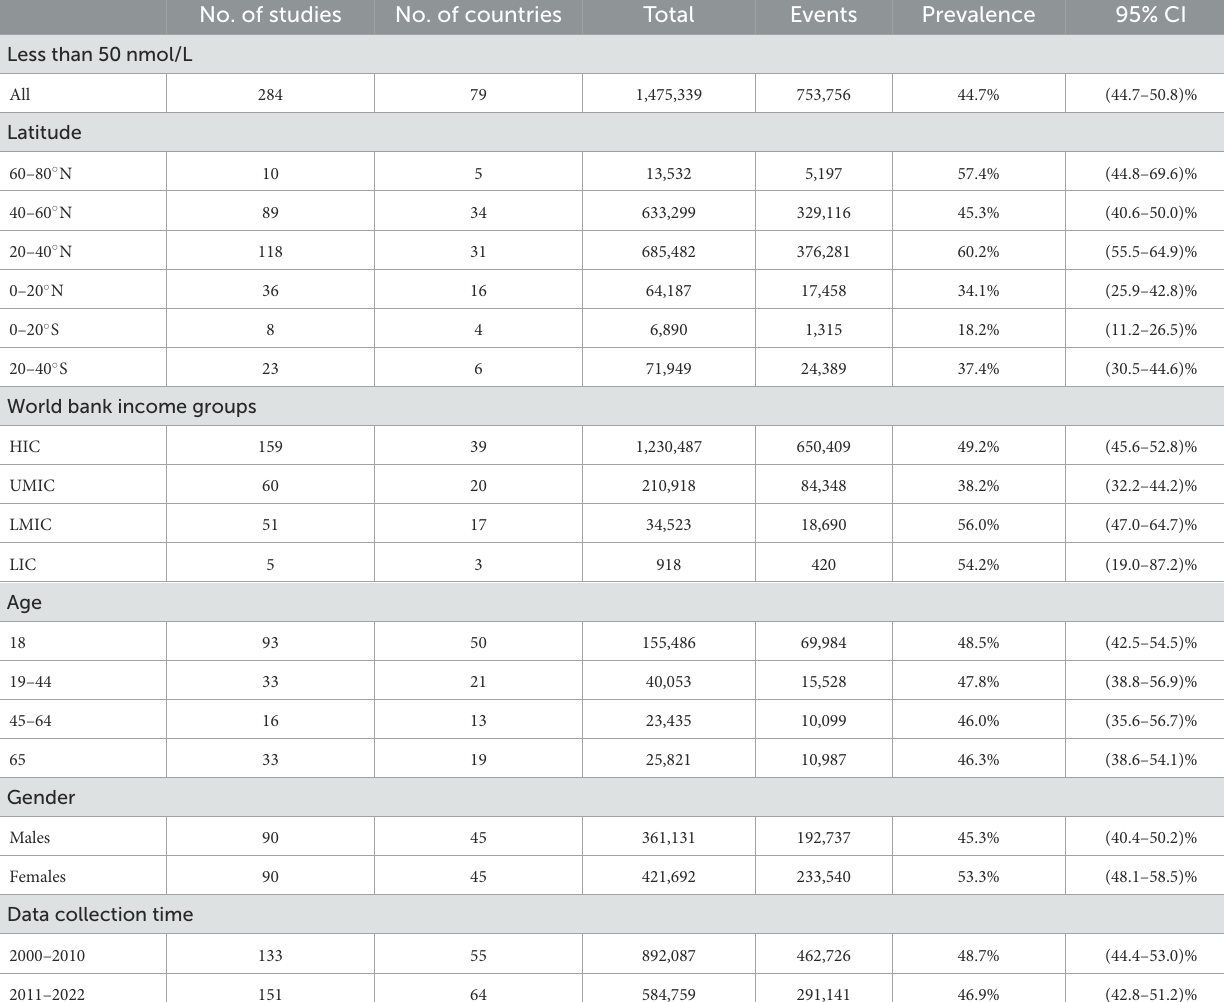
TABLE 2 The prevalence of serum 25-hydroxyvitamin D levels < 50